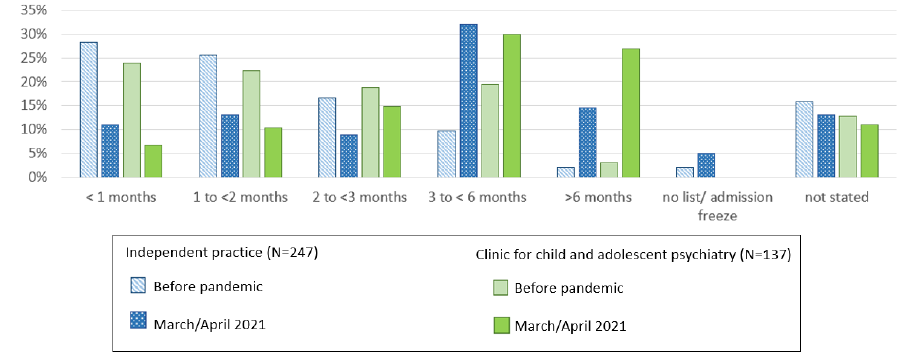
Figure 1. Waiting time until initiation of treatment (months) before the pandemic and currently (March/April 2021) analyzed separately for professionals working in independent practices or in clinics for child and adolescent psychiatry (percentage of responses of each group). Table 3. Treatment waiting time, adjustments, and evaluation of supply in March/April 2021 compared to before the